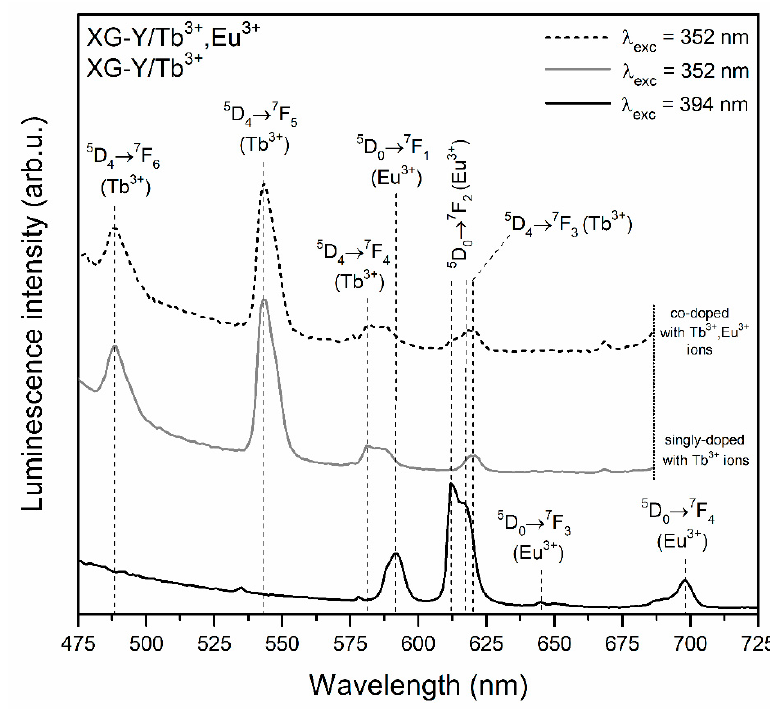
Figure 4. Photoluminescence (PL) spectra of XG-Y / Tb 3 + and XG-Y / Tb 3 + ,Eu 3 + samples recorded upon near-ultraviolet (NUV) illumination at λ exc = 352 nm and λ exc = 394 nm.